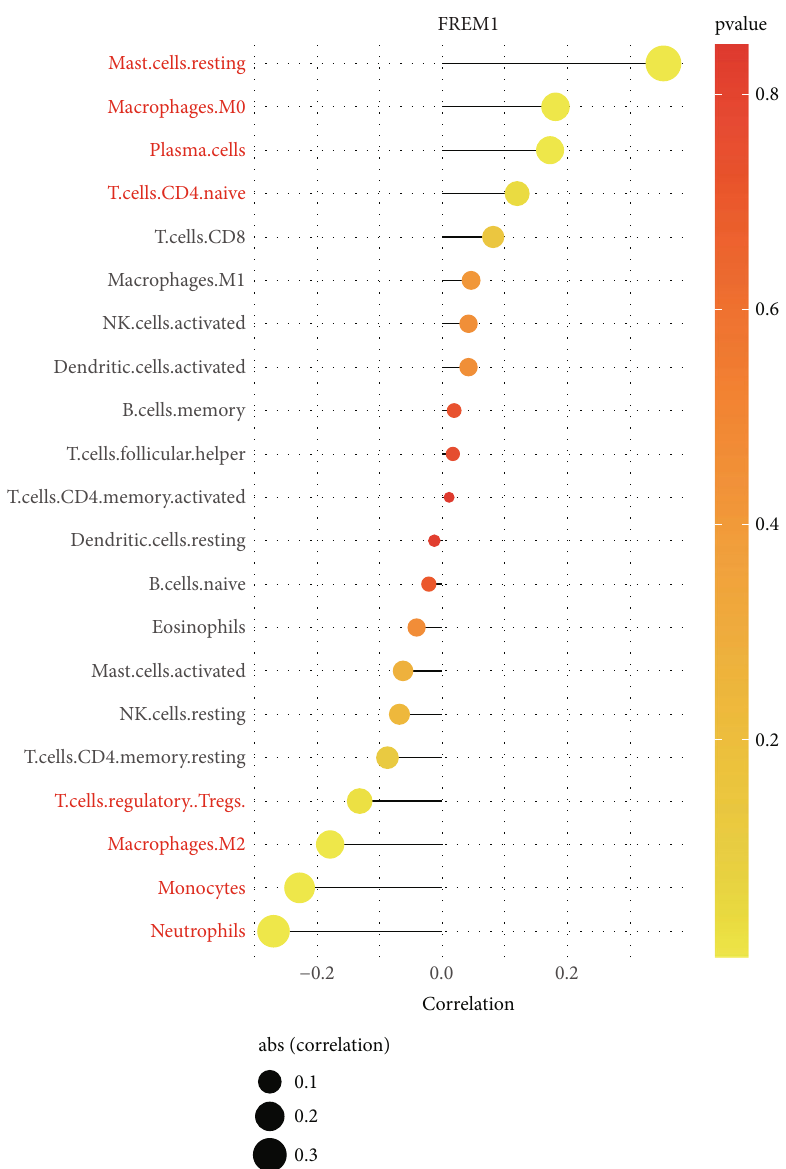
Figure 6: Correlation between FREM1 and immune cell subtypes. The size of each dot in the fi gure represents the degree of correlation. Larger dots represent a high degree of correlation. The speci fi c P value is shown in yellow and red; the smaller the P value, the more obvious the yellow point. All immune cell names with P < 0 : 05 are marked in